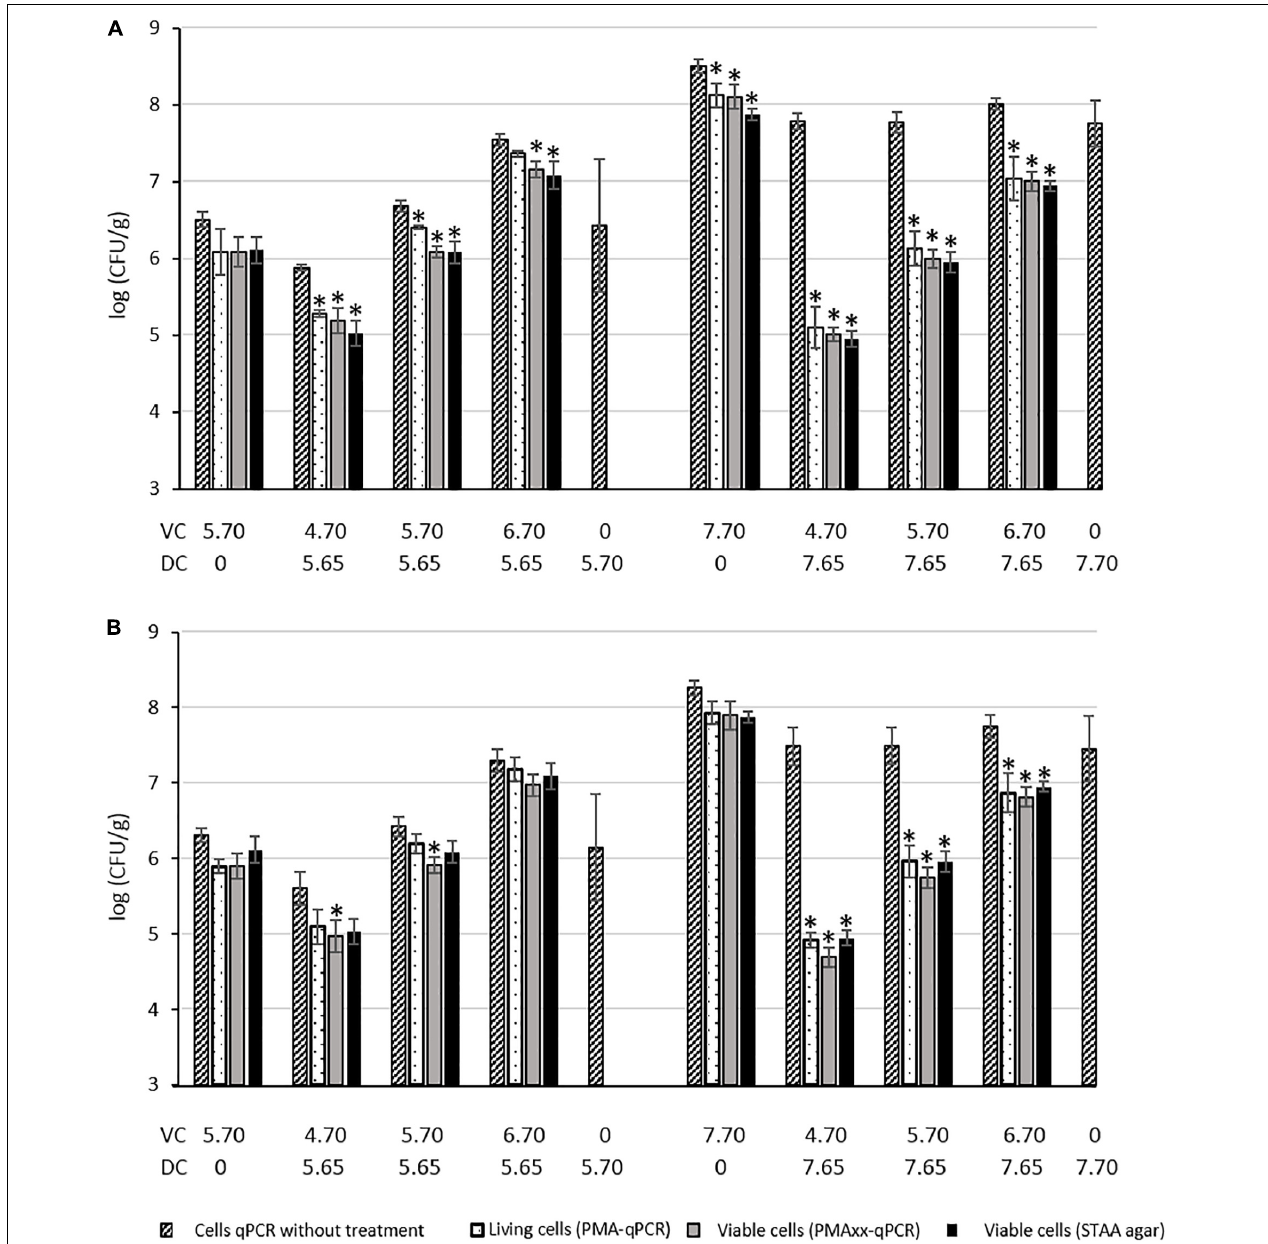
FIGURE 1 | Quantification of dead (DC) and viable (VC) B. thermosphacta cells mixed in smoked salmon tissue homogenate (SSTHs) with plating enumeration on STAA medium, and PMA or PMAxx qPCR using the rpoC-126F/R (A) or rpoB-Fw1/Rev1 (B) primer sets. Results expressed in log CFU/g. *significant difference between quantification results of untreated cells obtained by qPCR method and treated cells quantified by qPCR method or plating